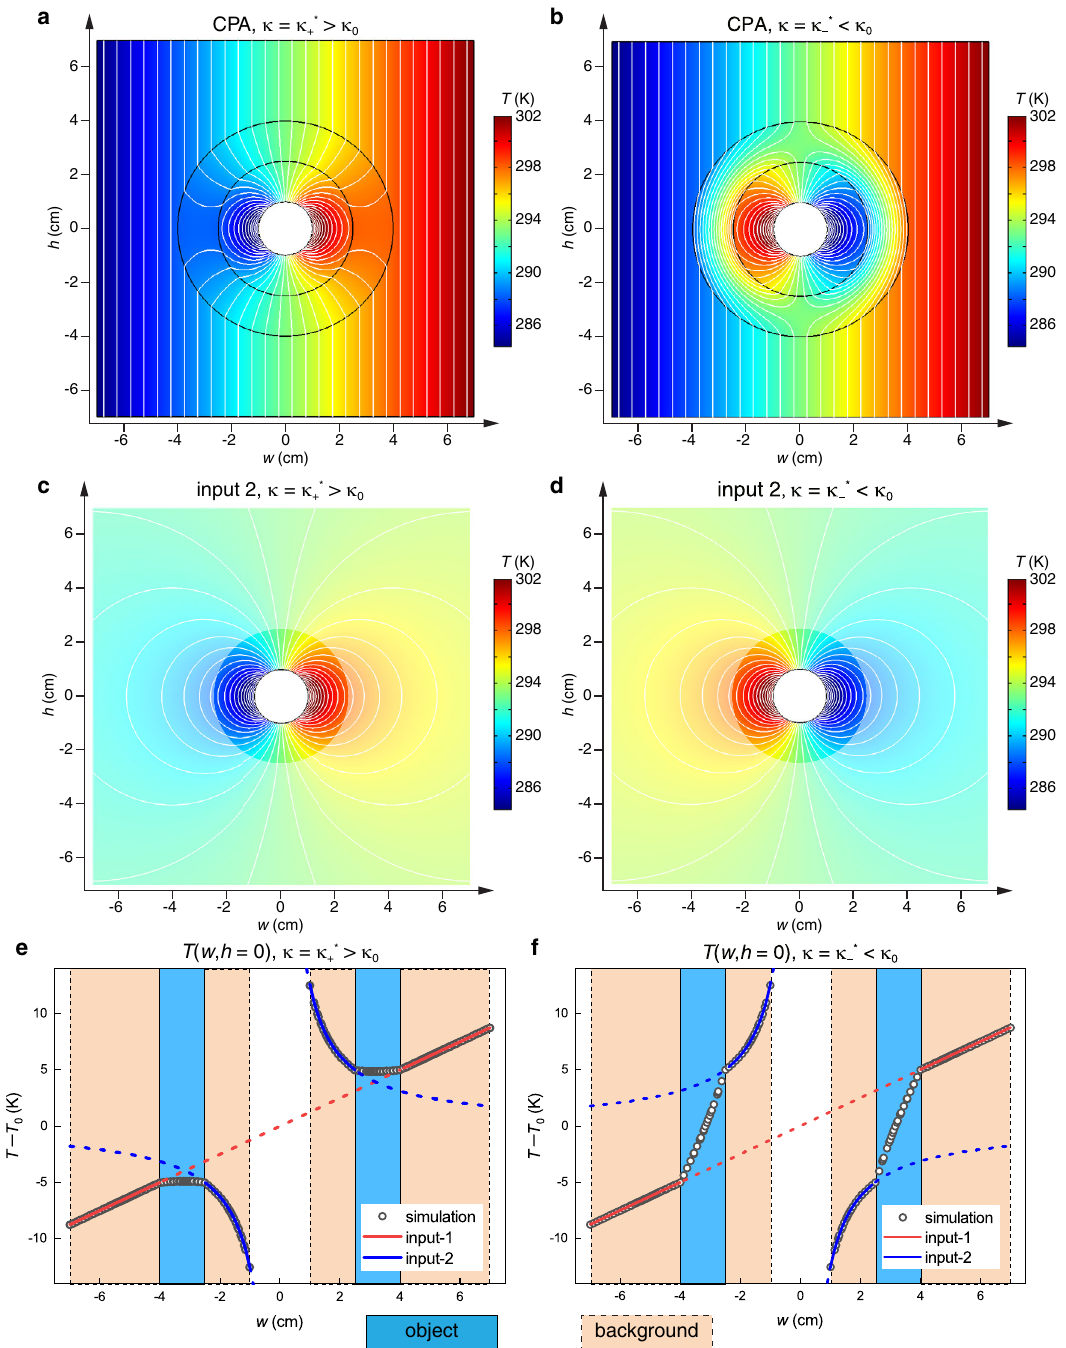
Fig. 2 Thermal coherent perfect absorption (CPA). The thermal conductivity κ of the ring-shaped object is ( a , c , e ) larger or ( b , d , f ) smaller than that of the background κ 0 . a , b The temperature distributions on the entire system with isothermal lines (white). c , d The temperature distribution of input-2 on a pure background that is much larger ( L = 1 m) than the displayed part ( L = 14 cm). e , f Temperature distributions along the line h = 0. The regions of the background (beige) and the object (light blue) are shaded. The incident fi elds input-1 (red) and input-2 (blue) are also outside (inside) the object (scatters) are consistent with the input- 1 (input-2) fi eld (solid lines), indicating no outgoing fi eld on either side of the object. The results are similar to the numerical results in Fig. 2e, f.